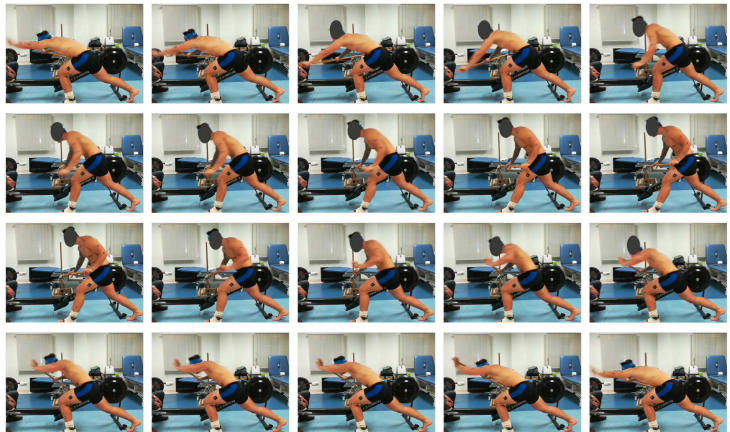
Figure 4. A sequence of images showing a typical standing rowing cycle as performed in the lab, with the first two rows of images showing the “recovery” phase (starting from the “finish” position) and the last two rows showing the “drive” phase (starting from the “catch”, ending with the